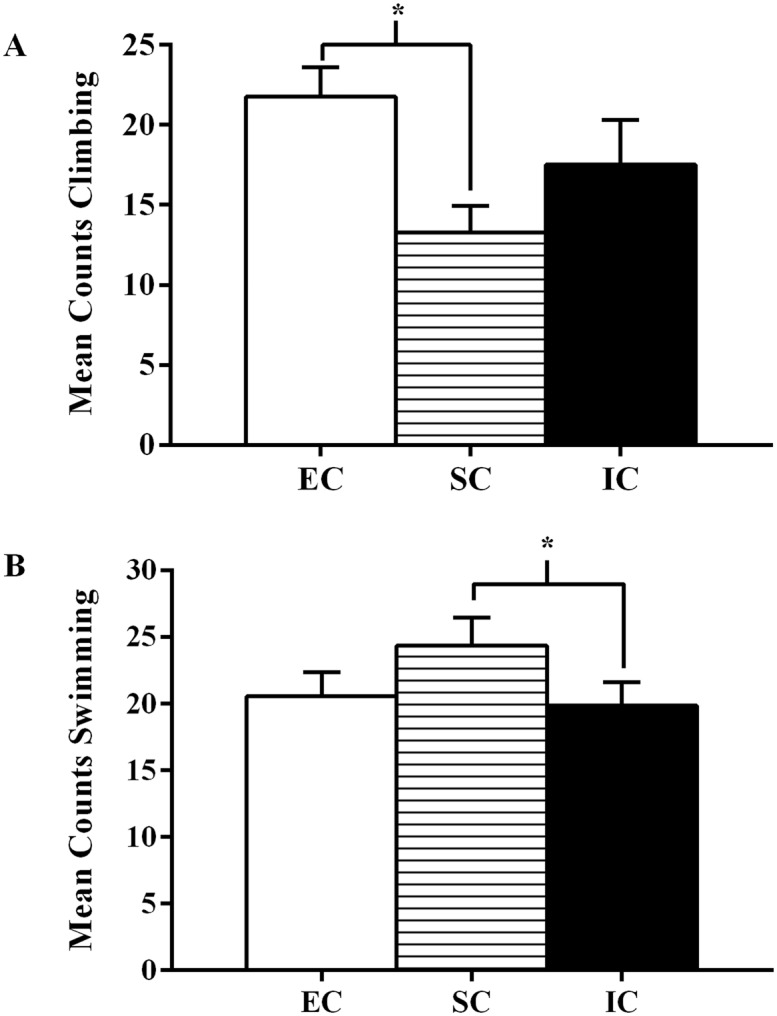
Experiment III Pretest Climbing and Swimming.Experiment III total mean counts (±SEM) of (A) climbing and (B) swimming behavior between EC, SC, and IC rats during the first five minutes of the forced swim pretest. (A) Asterisk (*) indicates EC rats exhibited significantly more climbing than SC rats during the first five minutes of the pretest. (B) Asterisk (*) indicates IC rats exhibited significantly less swimming than SC rats during the first five minutes of the pretest (p < .05).